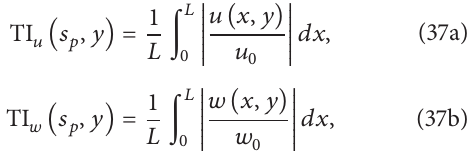
distance ( 𝑦/𝑎 𝑠 = 150 ), whether SH or P waves